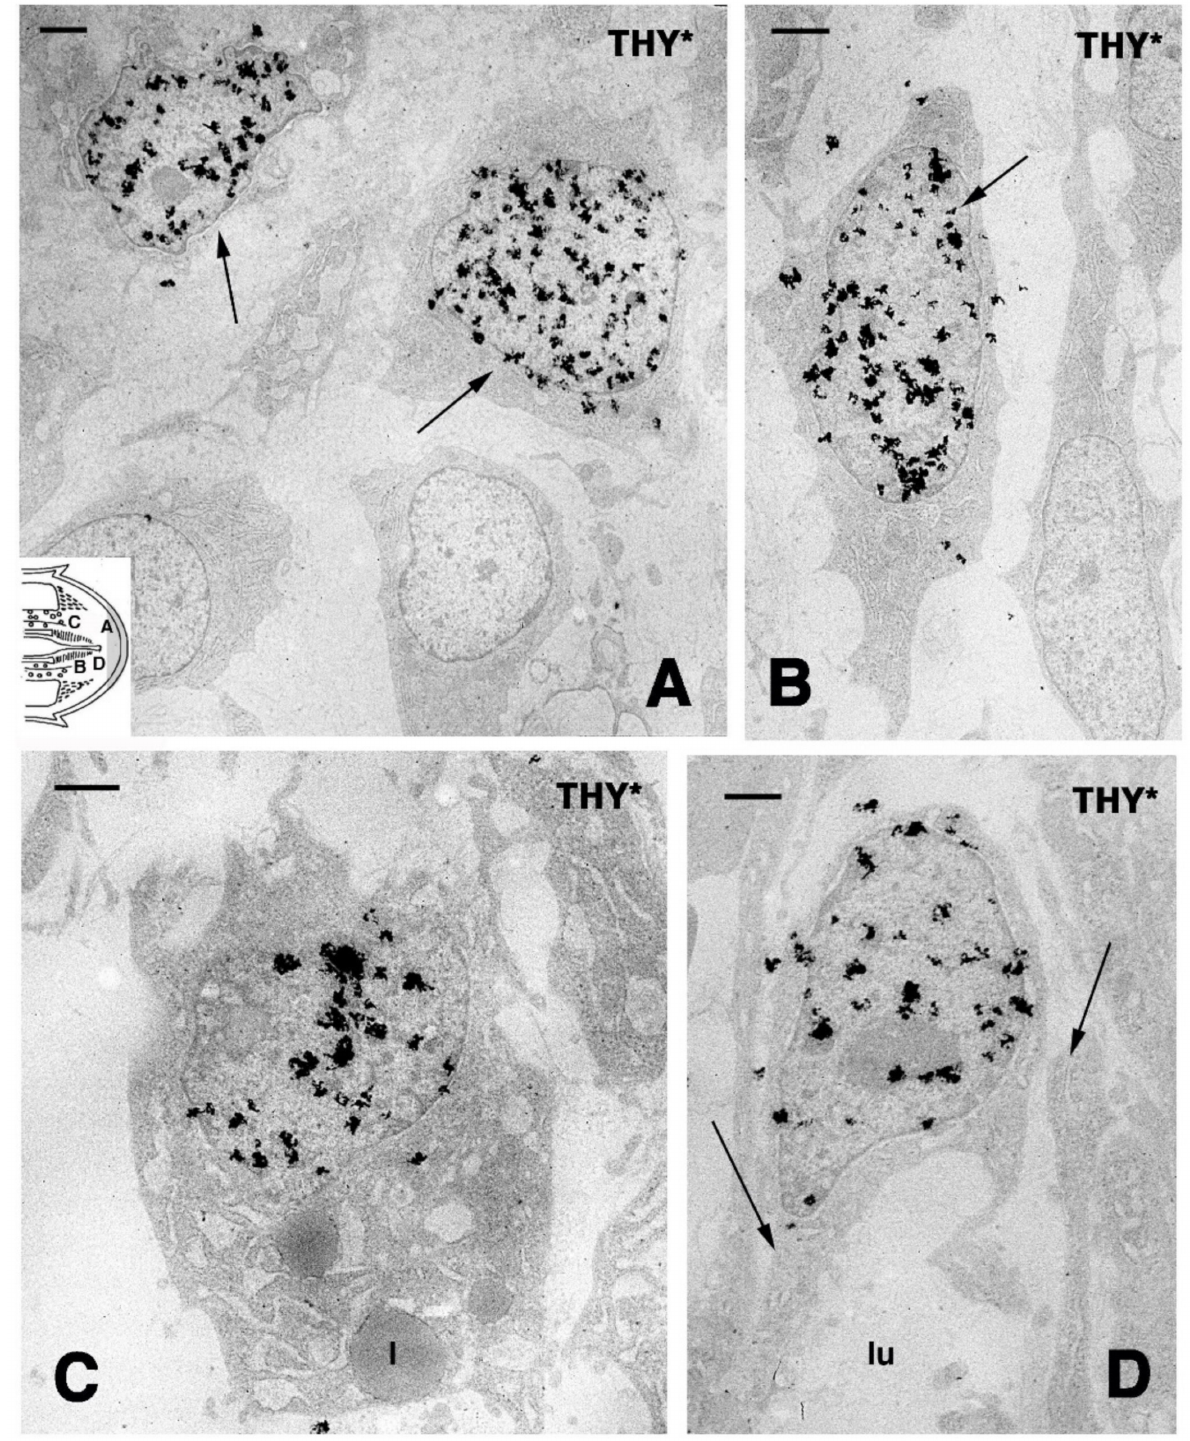
Figure 2. TEM autoradiography of blastema cells 4 h after injection of tritiated thymidine in Anolis carolinensis , showing nuclear labeling among different types of proliferating cells localized in the blastema (indicative positions shown by the letters in the inset drawing). ( A ) Mesenchymal cells with labeled nuclei (arrows) in the apical region near the epidermis. Bar, 1 µ m. ( B ) Elongated fibroblast with labeled nucleus (arrow) detected in front of a vertebra fragment in the stump. Bar, 1 µ m. ( C ) Labeled cells storing lipid droplets (l) and localized near the peri-vertebral fat layer of the tail stump. Bar, 1 µ m. ( D ) Labeled endothelia cells (arrows point the vessel wall) of the forming capillary (lu, lumen) inside the blastema. Bar, 1 µ